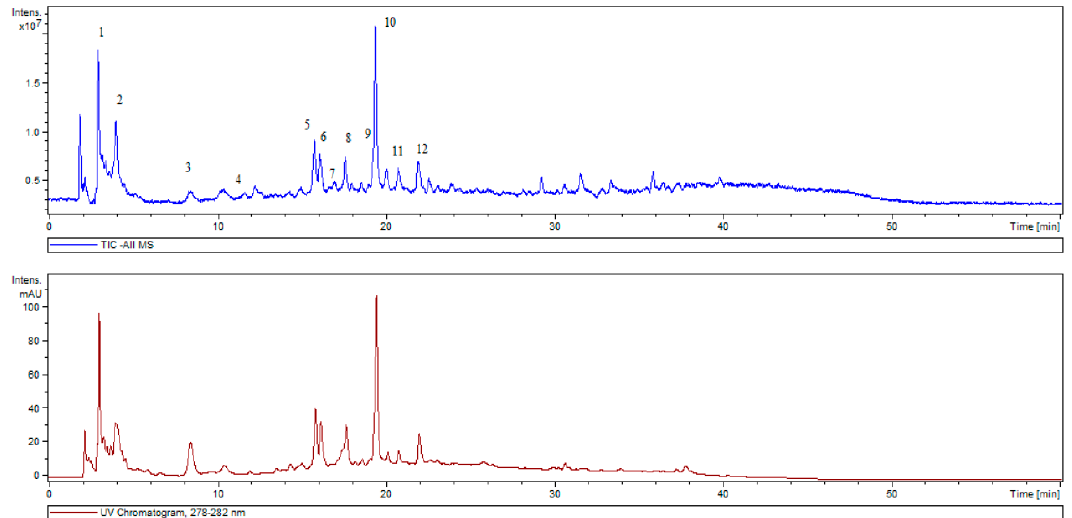
Figure 1. Total ion and UV chromatograms of Lavadula stoechas aqueous extract. Phytochemicals are numbered according to the retention time shown in Table 1.